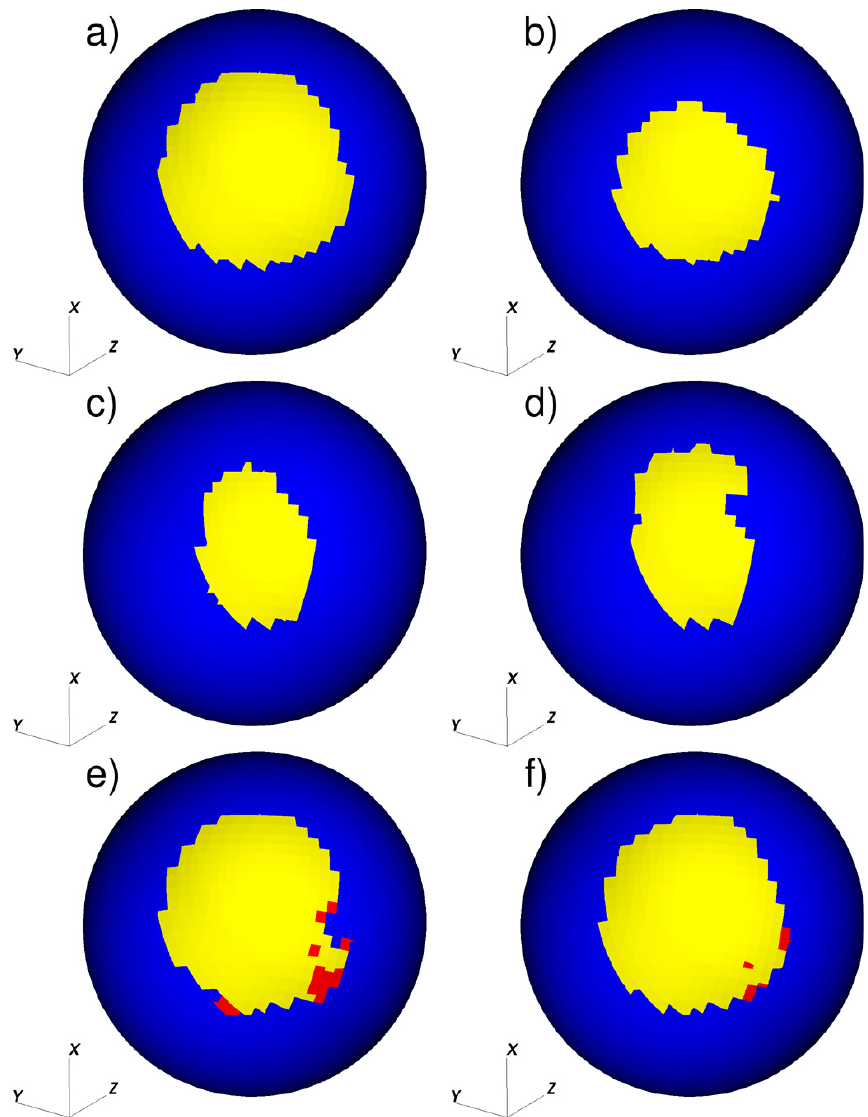
Fig. 12. The plasmoid footpoints at 4 R E in the Northern Hemisphere in the simulation are shown in red, other closed magnetic field lines in blue and northern lobe field lines in yellow. The same timesteps are shown as in Fig. 9: (a) 20:20, (b) 20:32, (c) 20:45, (d) 20:54, (e) 21:07 and (f)